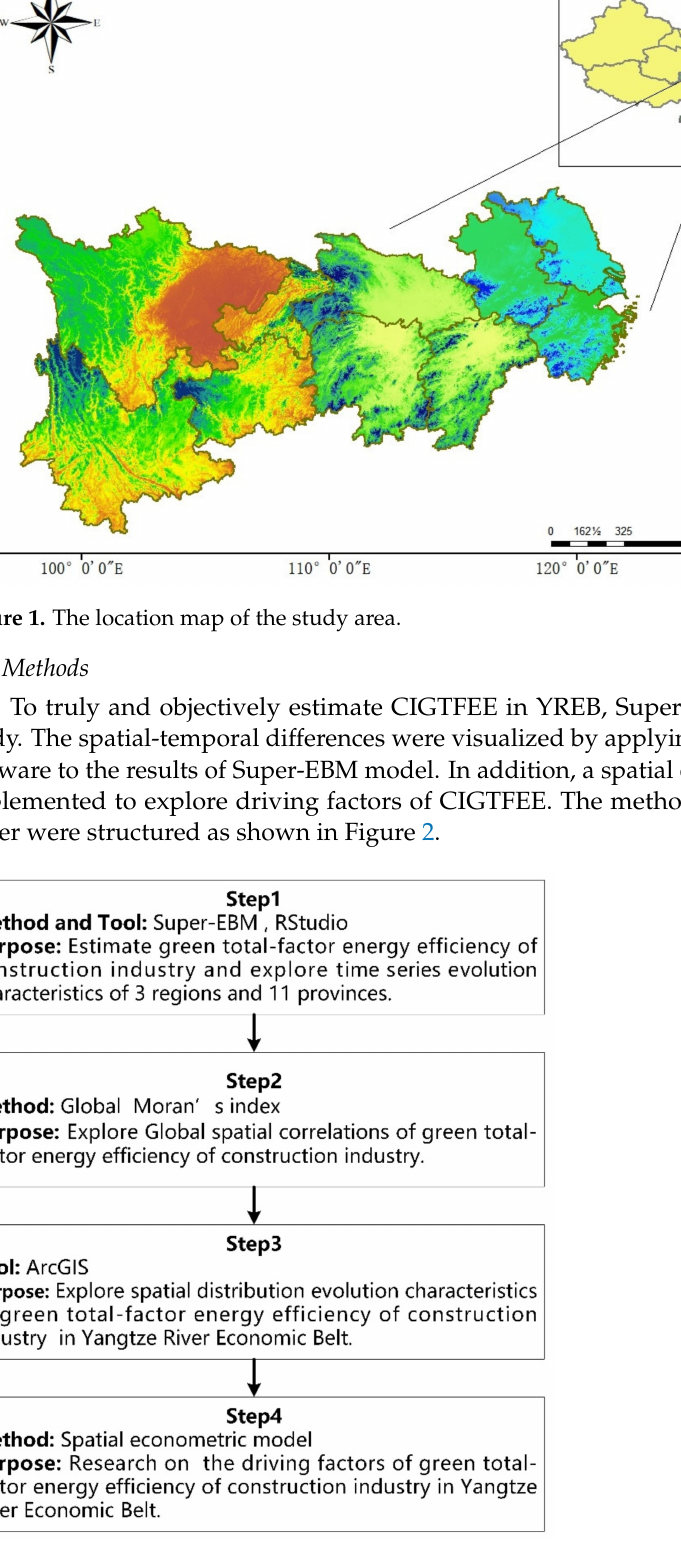
Figure 2. Overview of this